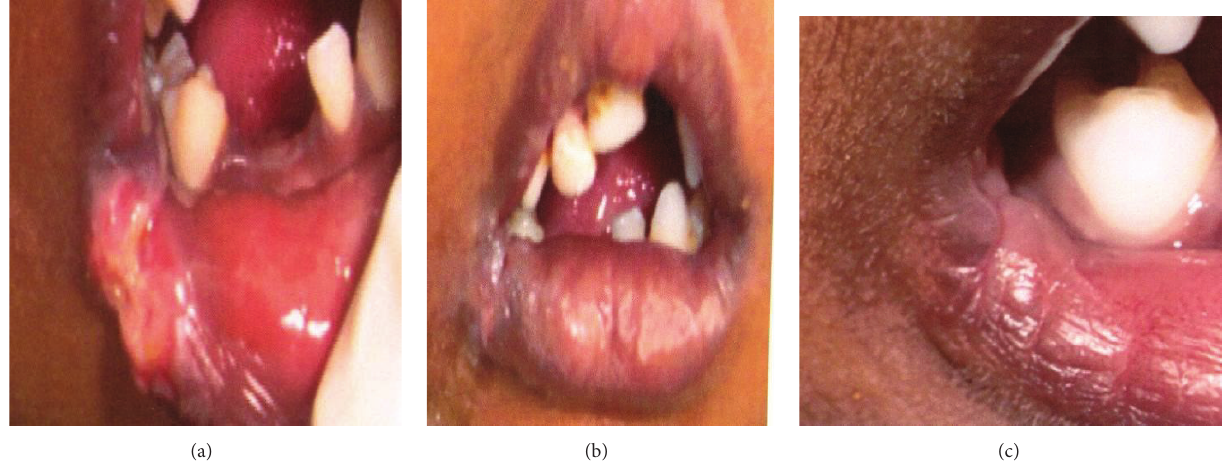
Figure 2: (a) Lacerated wound on lower lip. (b) Wound glued with cyanoacrylate. (c) 15th postoperative